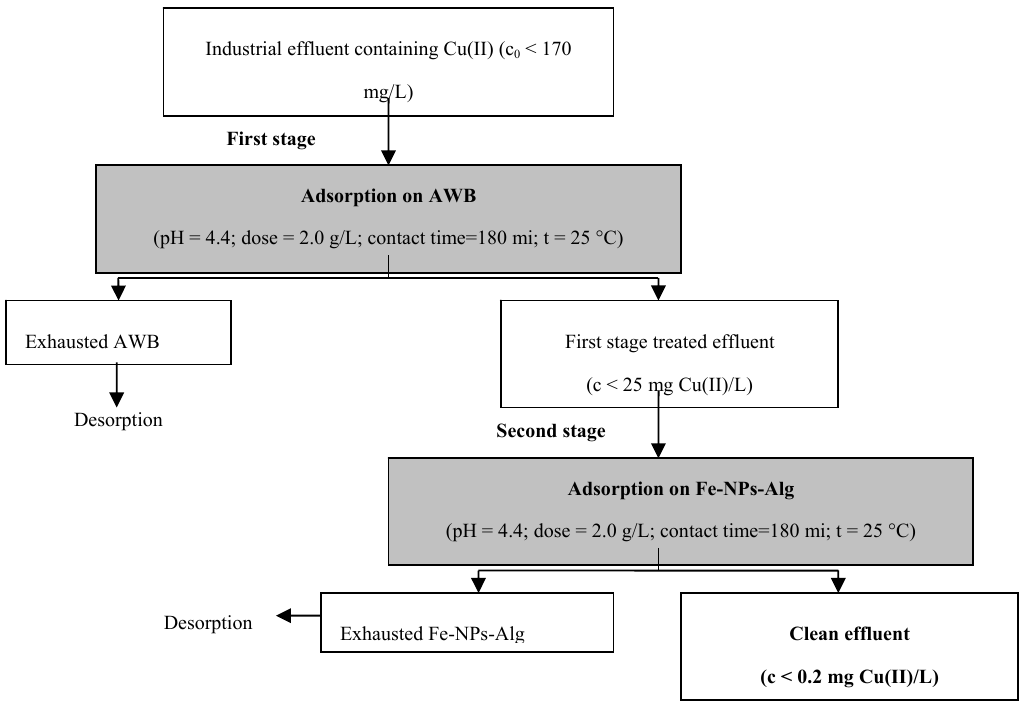
Figure 8. Schematic representation of the successive steps required to treat industrial effluents using AWB and Fe-NPs-Alg adsorbents.